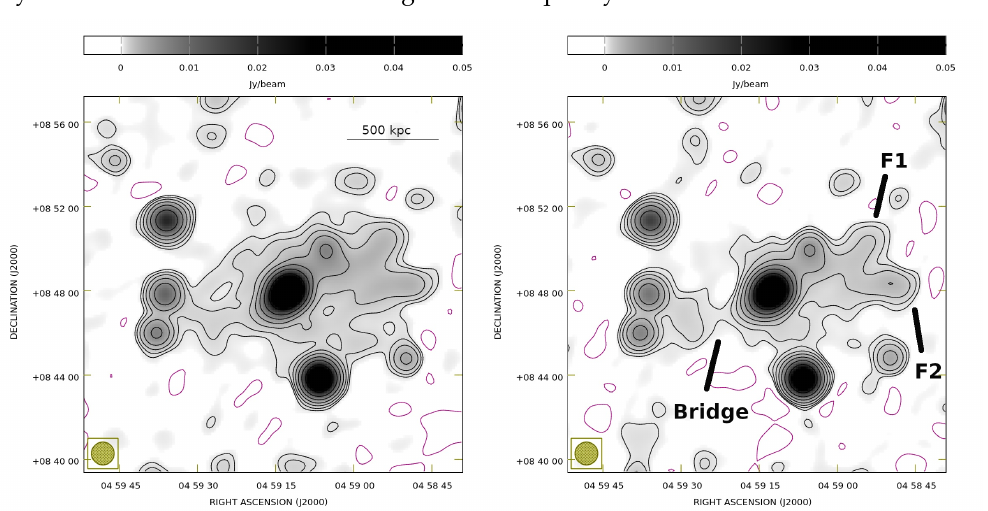
Figure 1. Radio emission in gray scale and contours of the galaxy cluster A523 at 1.410GHz (left panel, σ = 0.12mJy/beam) and at 1.782GHz (right panel, σ = 0.1mJy/beam). Black contours start at 3 σ and are spaced by a factor 2. Light magenta contours are drawn at − 3 σ . The resolution of the images is 65 (cid:48)(cid:48) . The synthesized beam is shown in the bottom left corner. These images are the same as in Vacca et al. submitted (see bottom panels in Figure 3 in that paper) but with a different uv -range, see the text for